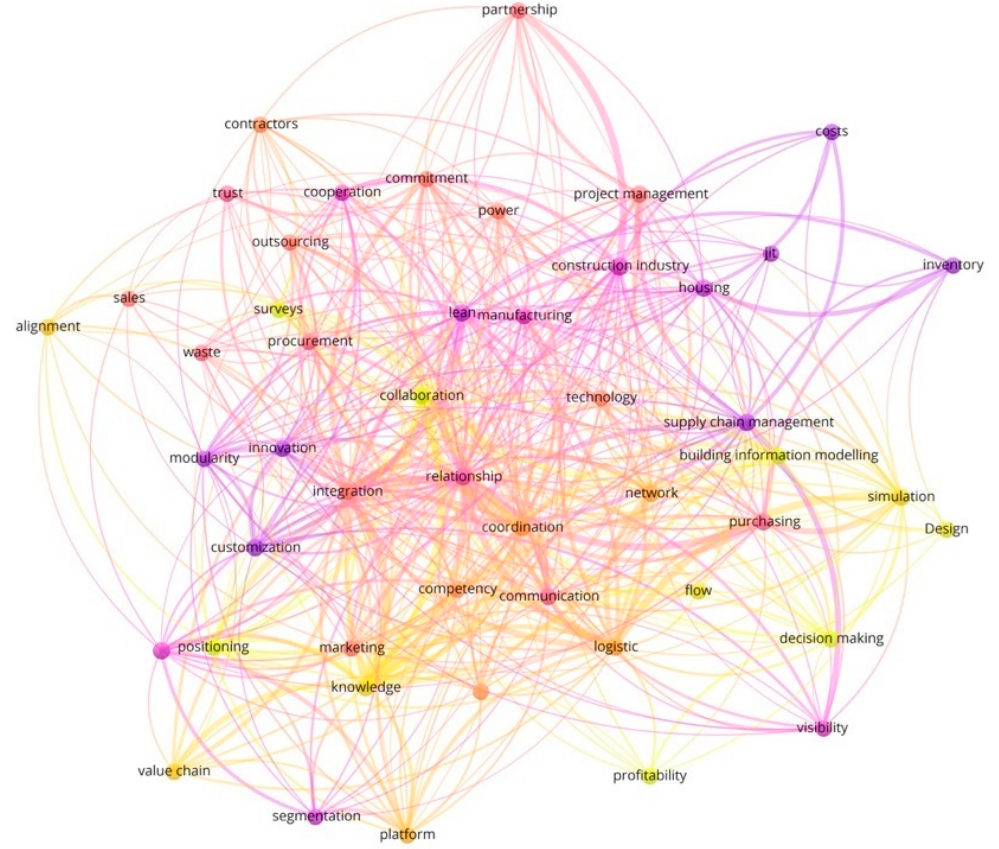
Figure 8. Mapping for most frequent words within PHB-SCM research .